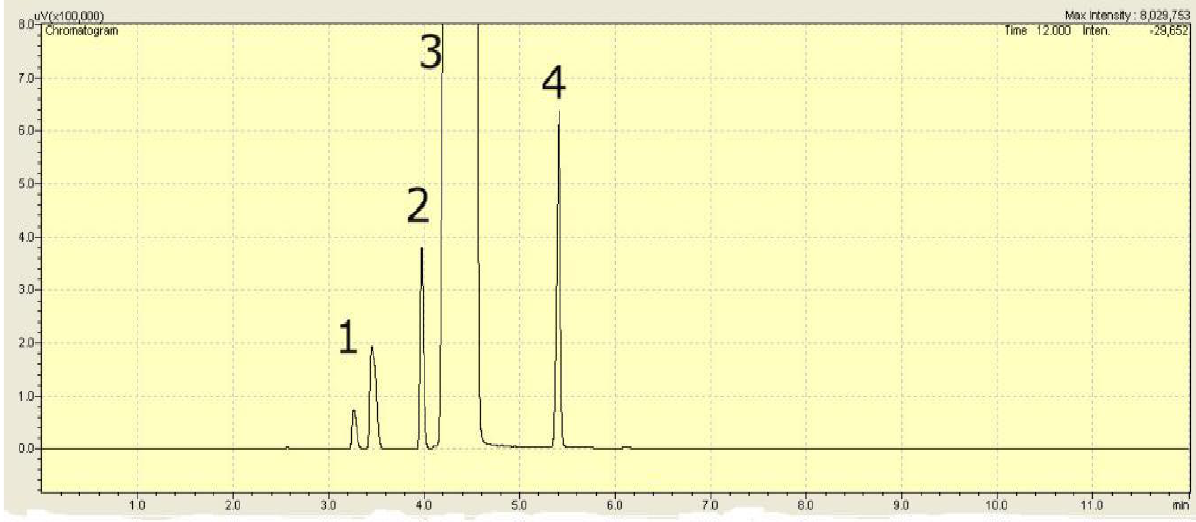
Figure 5. A sample chromatogram of GC-FID analysis with peaks; (1). Bioethanol. (2). Acetonitrile. (3). 1 − propanol. (4). Butanol.